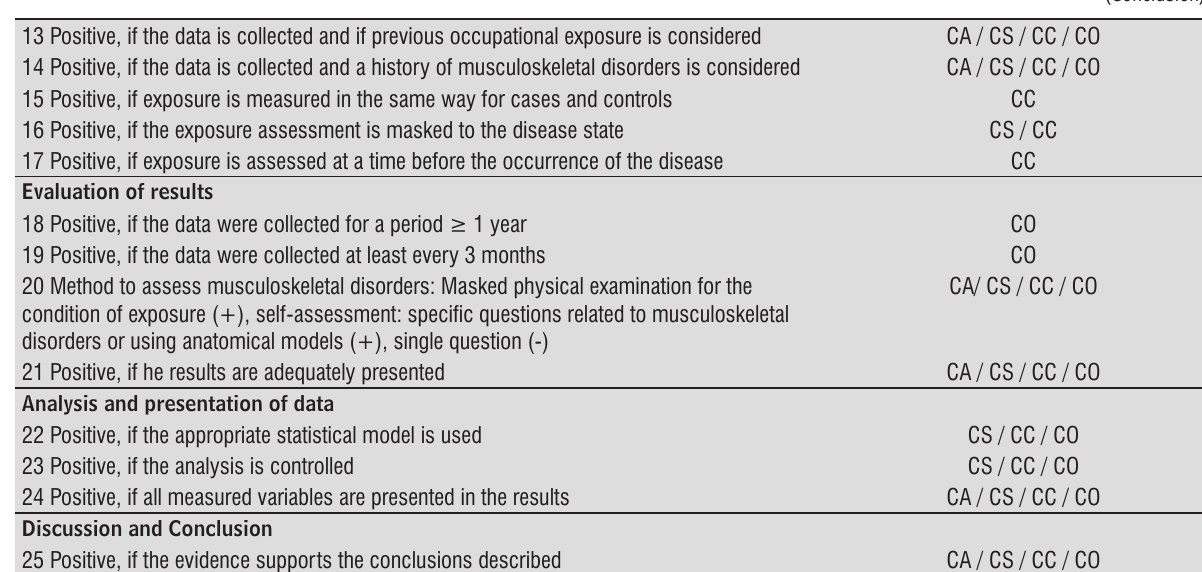
Table 1 - Standardized checklist of methodological quality of the cross-sectional (CS), case-control (CC) and cohort (CO) articles